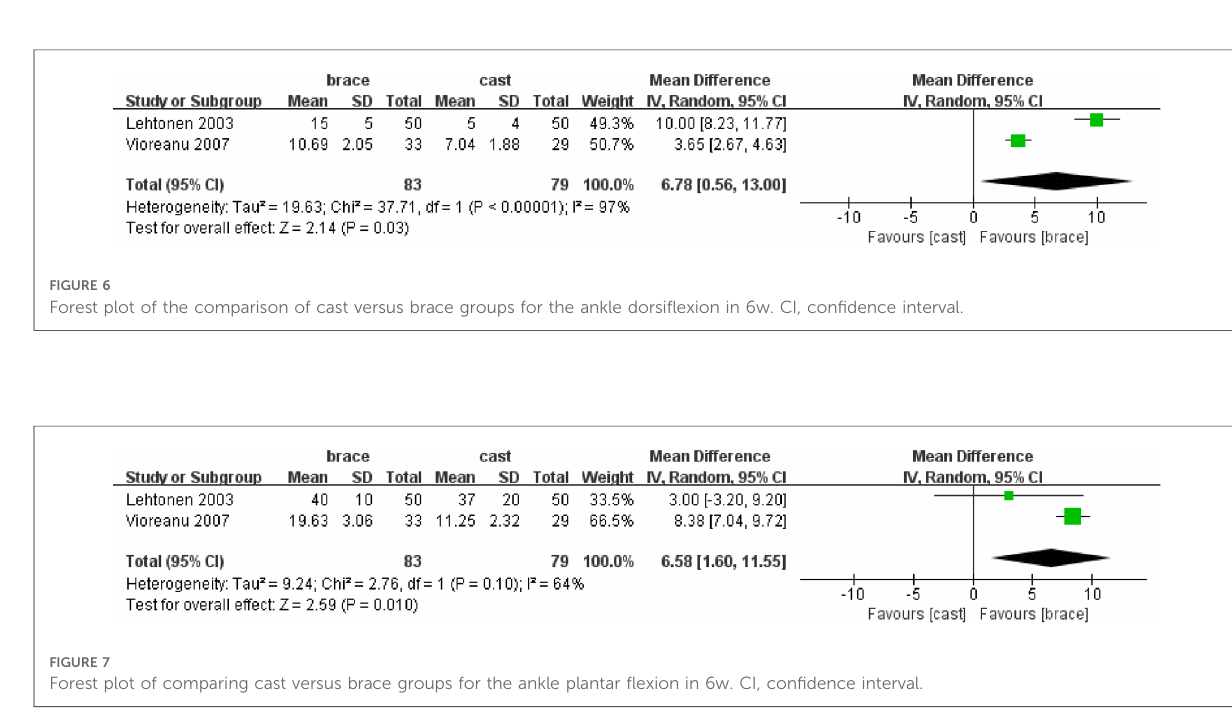
13.00, I 2 = 97%, p = 0.03; Figure 6 ) and plantar fl exion (mean difference 6.58, 95% CI 1.60 – 11.55, I 2 = 64%, p = 0.01; Figure 7 ) than the cast group in 6w.